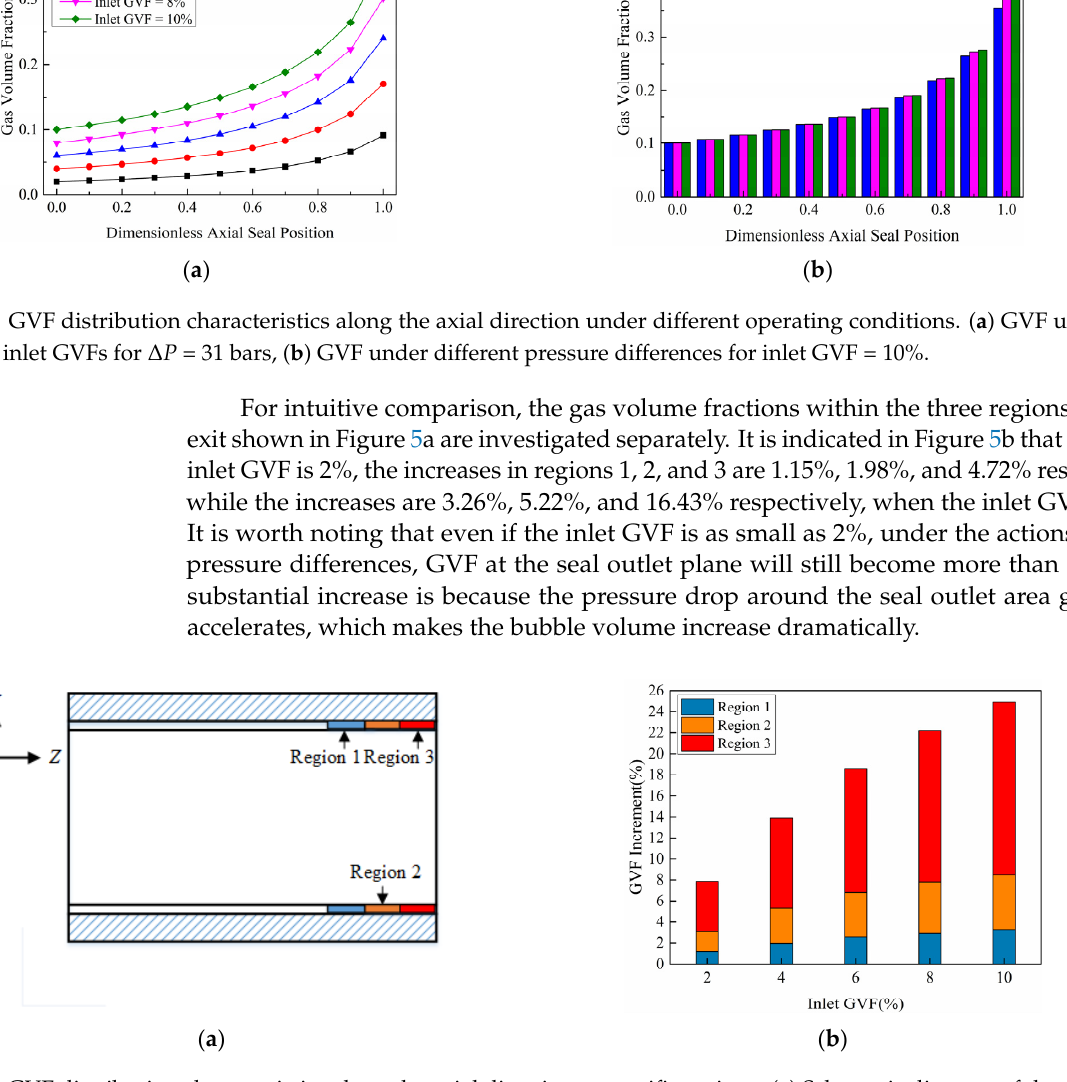
Figure 6. Mixture density along the axial direction under different conditions. ( a ) Under different inlet GVFs with a con- stant Δ P of 31 bars, ( b ) under different pressure differences with a constant inlet GVF of 10%.